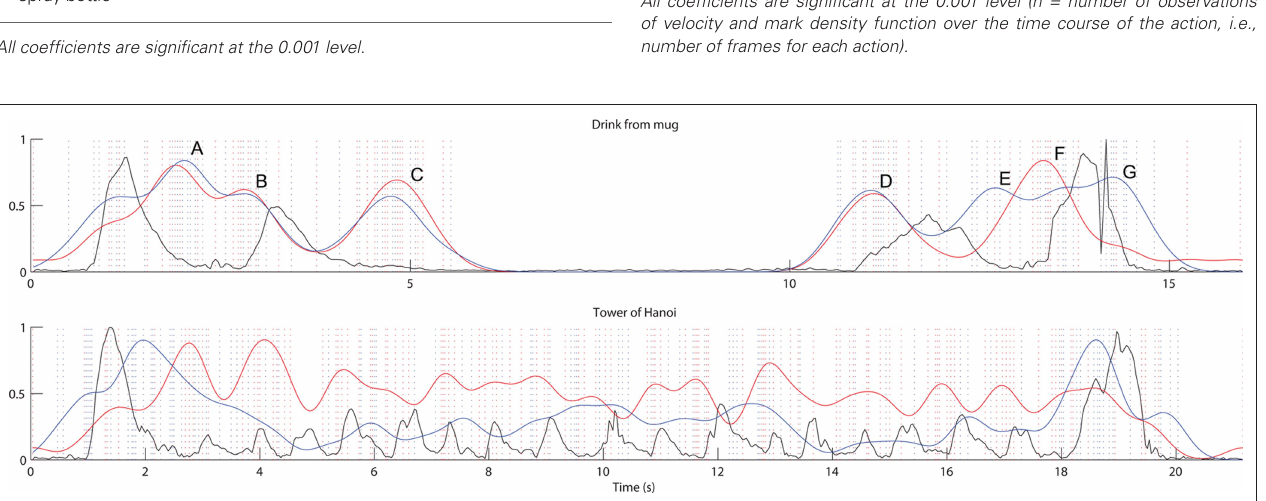
Figure 7 | relationship between density functions for the segmentation marks for the picture and no-picture-inverted groups for two actions. Black = velocity. Red = picture group. Blue = no-picture group. Dotted vertical lines indicate marks placed by participants in the picture (red) and no-picture group (blue)